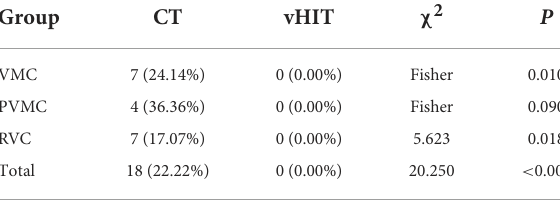
TABLE 5 Comparison of abnormal result rates between CT and